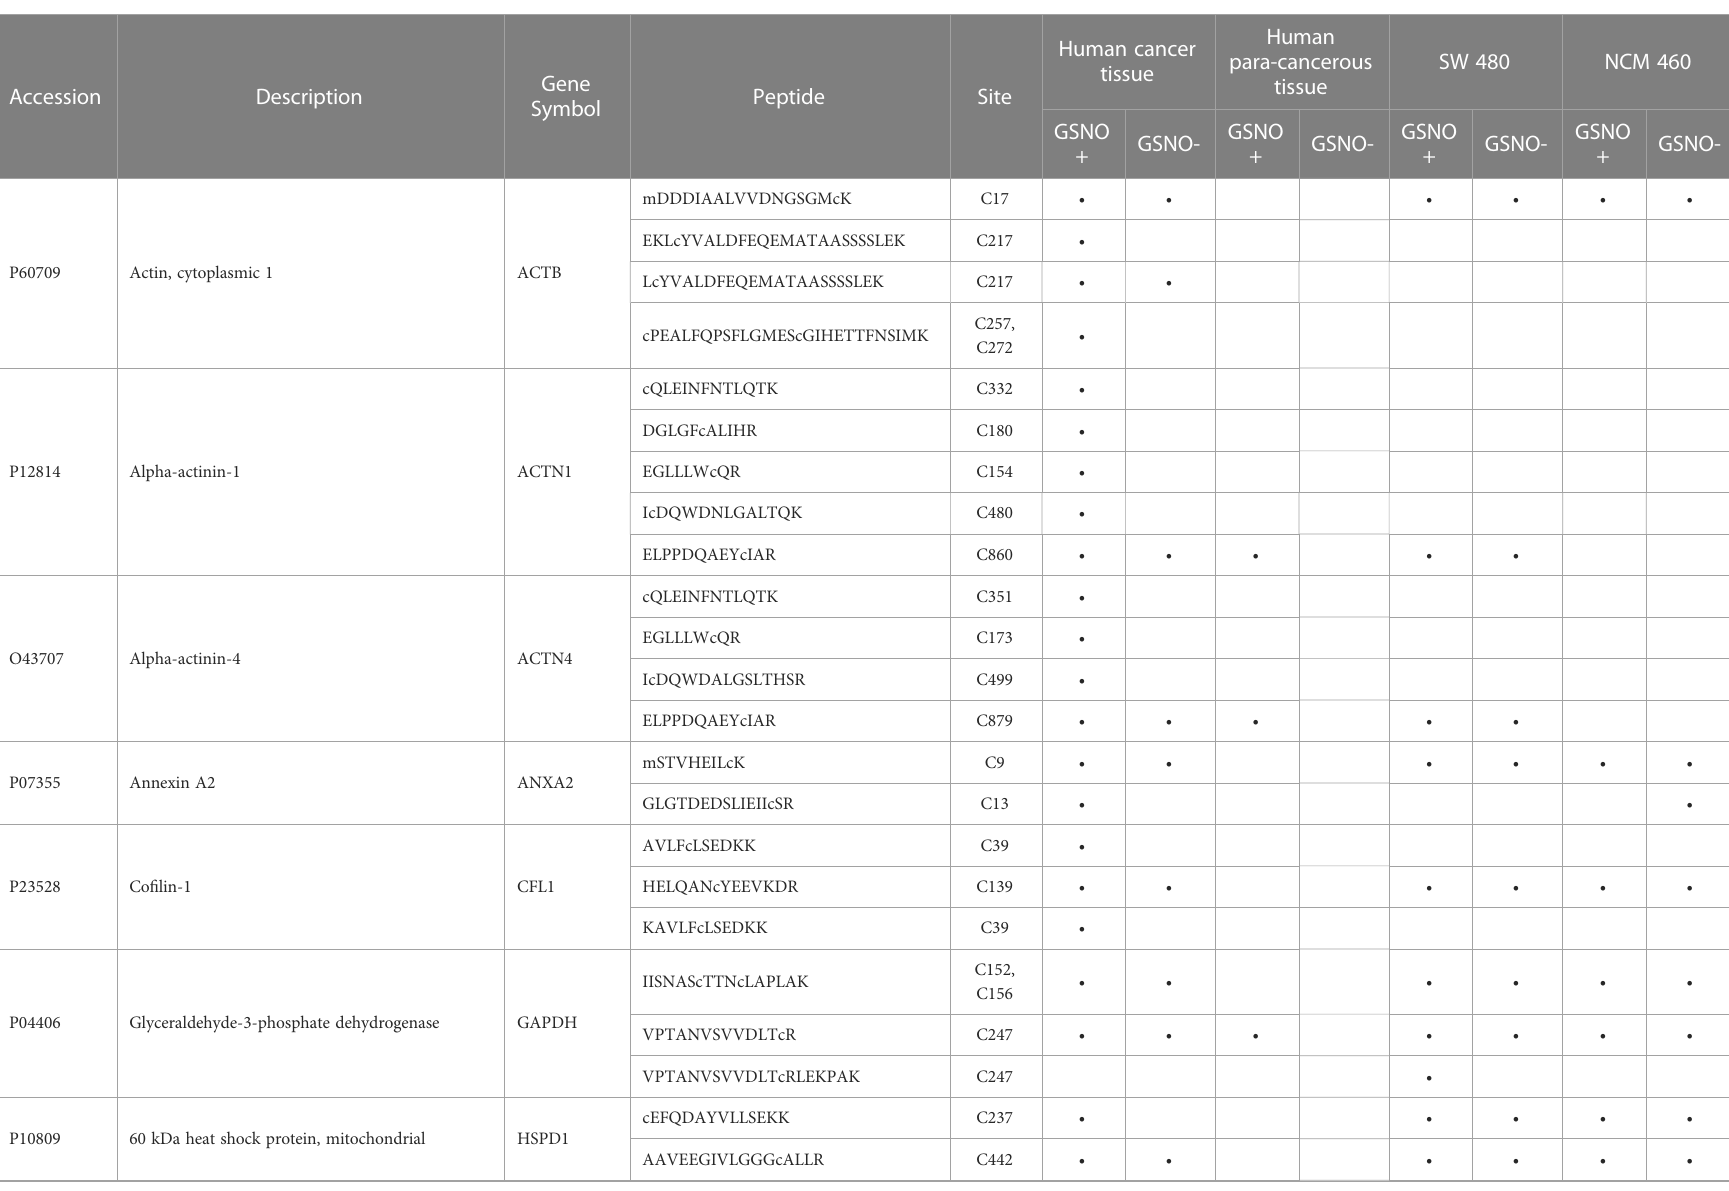
TABLE 2 List of different SNO sites of the same protein in the above 19